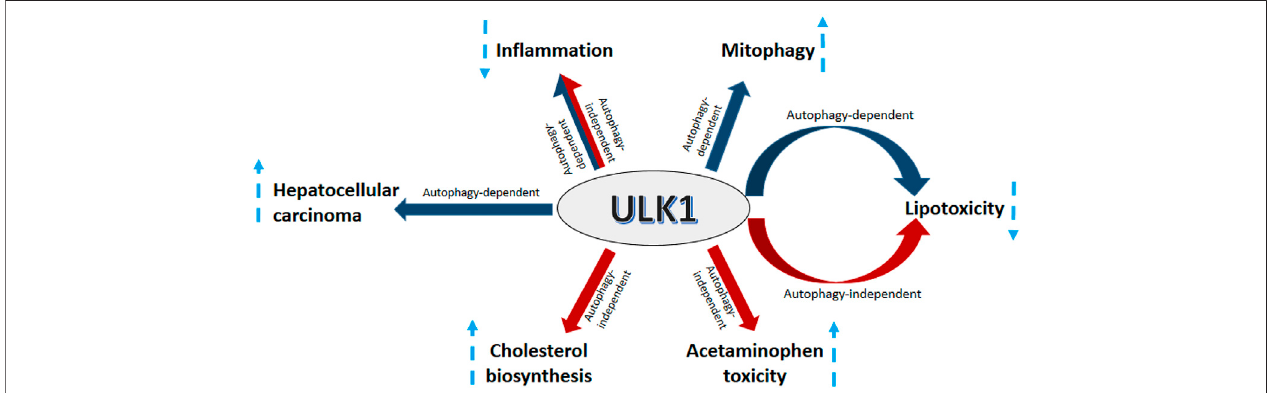
FIGURE4| ULK1signalingintheliver.Uncoordinated-51-likekinases1(ULK1)regulatesseveralaspectsofliverphysiologyand pathophysiology.ULK1increases hepatic mitochondrial activity and lipid metabolism via induction of mitophagy. Additionally, ULK1 also supports HCC growth by regulating the expression of forkhead box protein M1 (FOXM1). ULK1 also mitigates lipid induced lipotoxicity and in fl ammation via both autophagy and non-autophagy mechanisms. Furthermore, ULK1 also increases acetaminophen (APAP) toxicity and hepatic cholesterol synthesis via a non-canonical autophagy independent